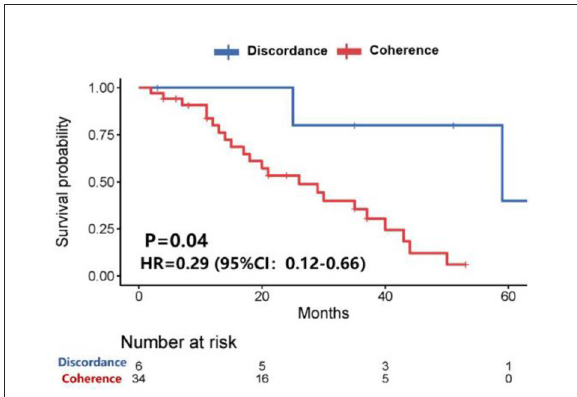
FIGURE3 Survival curves of patients with consistent HER-2 expression vs. patients with inconsistent HER-2 expression after diagnosis of brain metastases.